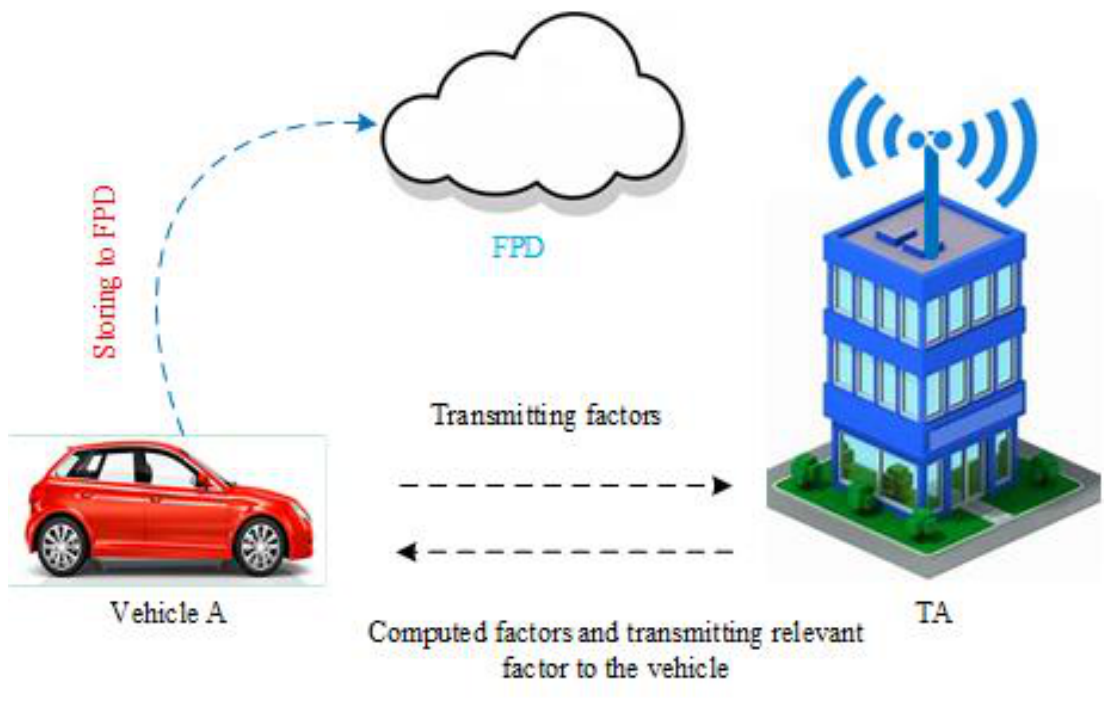
Figure 4. Vehicle authentication process in A-MAC